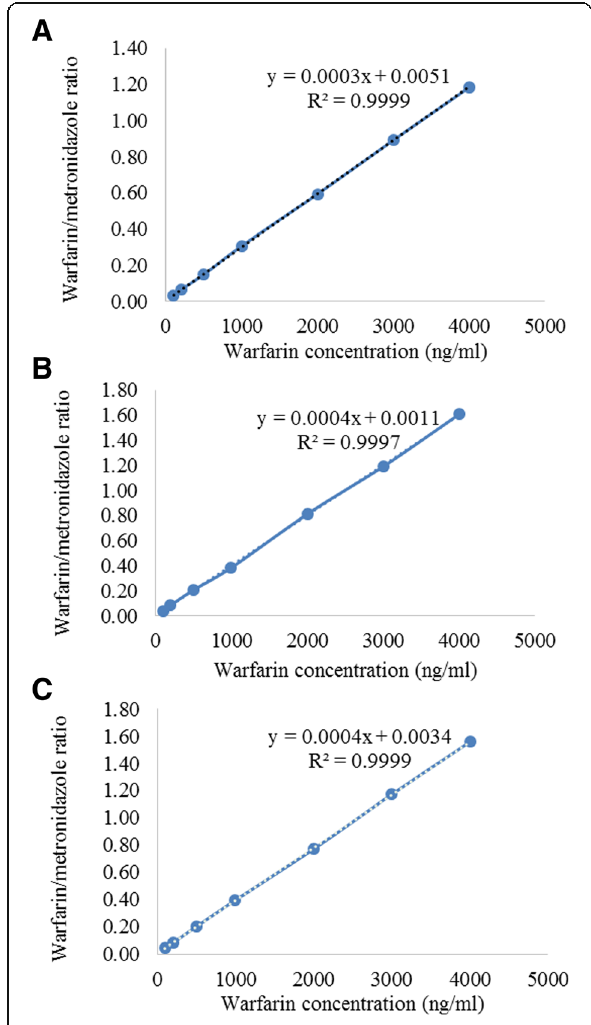
Fig. 1 Calibration curves of warfarin HPLC analysis at ( a ) day 1 ( b ) day 2 ( c ) day 3